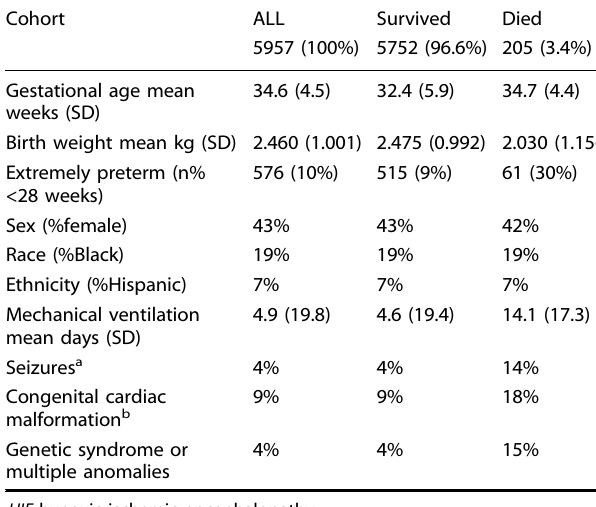
Genetic syndrome or multiple